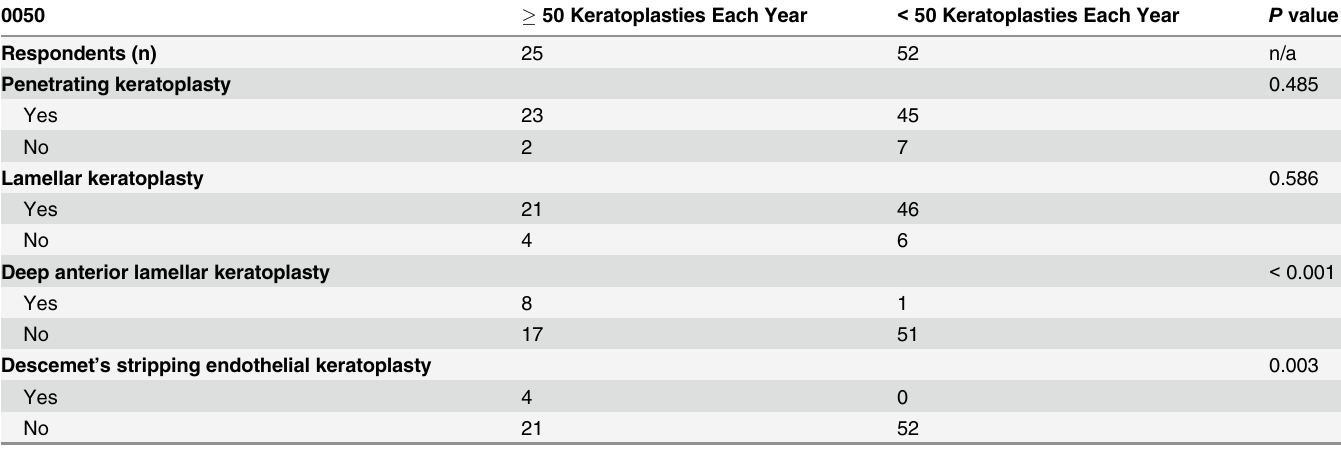
Table 4. Keratoplasty Patterns among Chinese Corneal